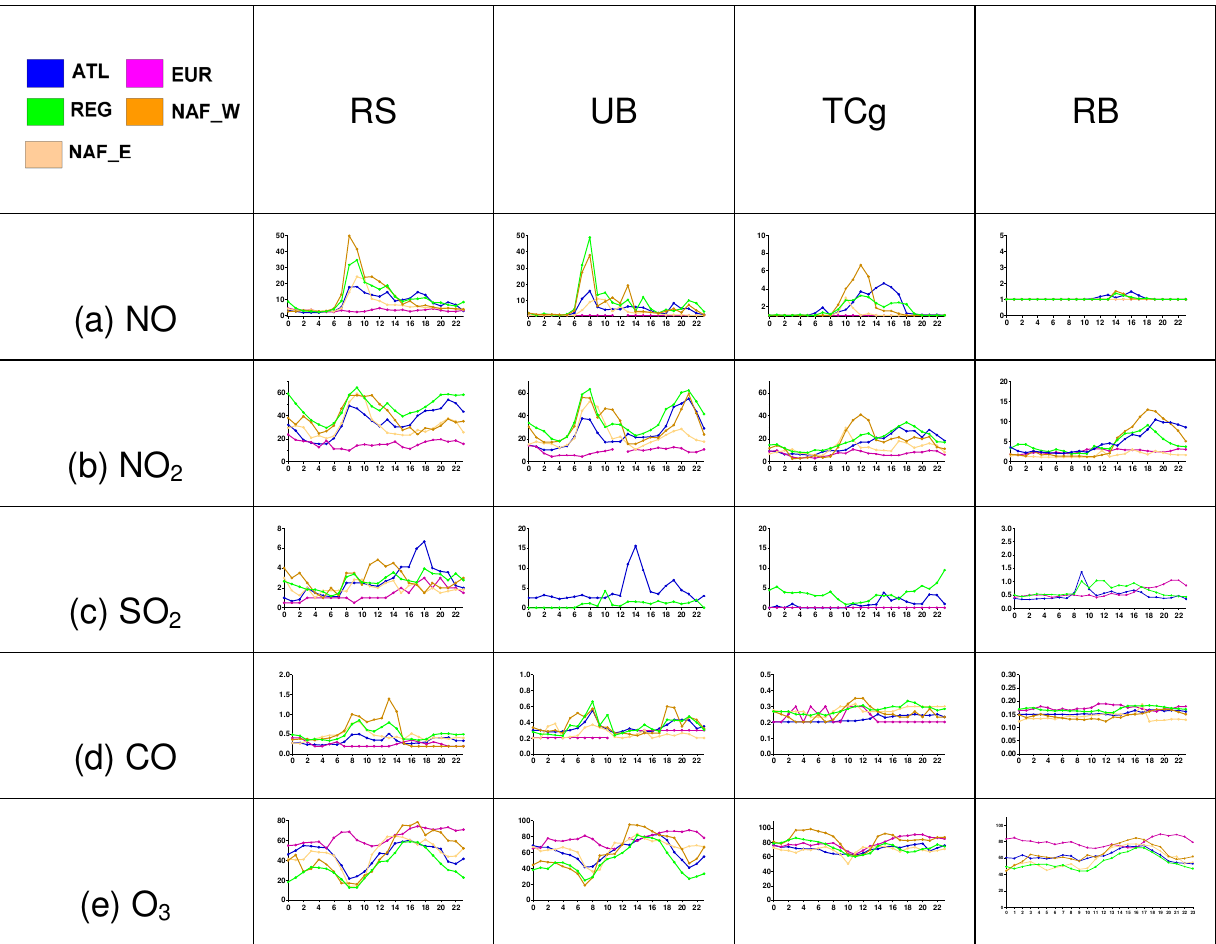
Fig. 9. Diurnal variation at four different monitoring sites for (a) NO, (b) NO 2 , (c) SO 2 , (d) CO, (e) O 3 for different air mass types. Please note all concentrations are in µg m − 3